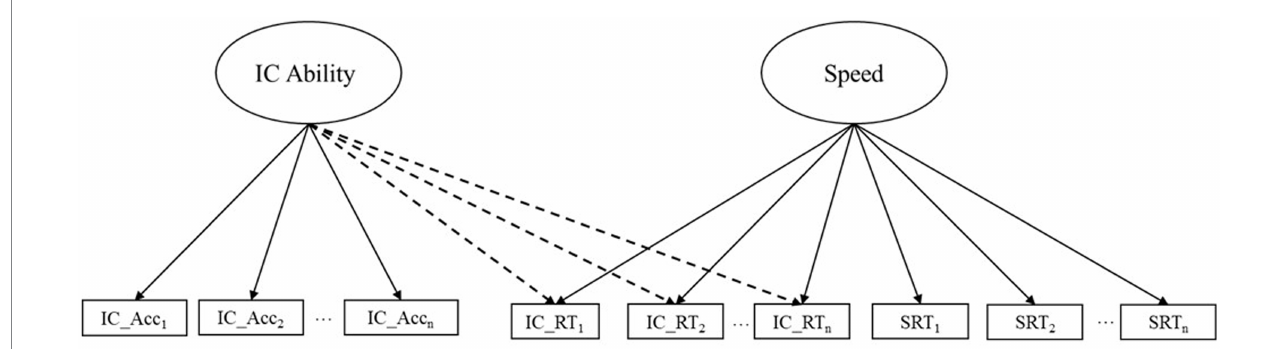
FIGURE 1 Exemplary two-factor confirmatory factor model for obtaining enriched scores. This model depicts the use of item-level accuracy and RT information from a generic inhibitory control task and item-level RT information from a simple reaction time task to create enriched inhibitory control scores. Dashed lines indicate cross-loadings. IC, inhibitory control; IC_Acc, accuracy from inhibitory control task; IC_RT, reaction time from inhibitory control task; SRT, reaction time from simple reaction time